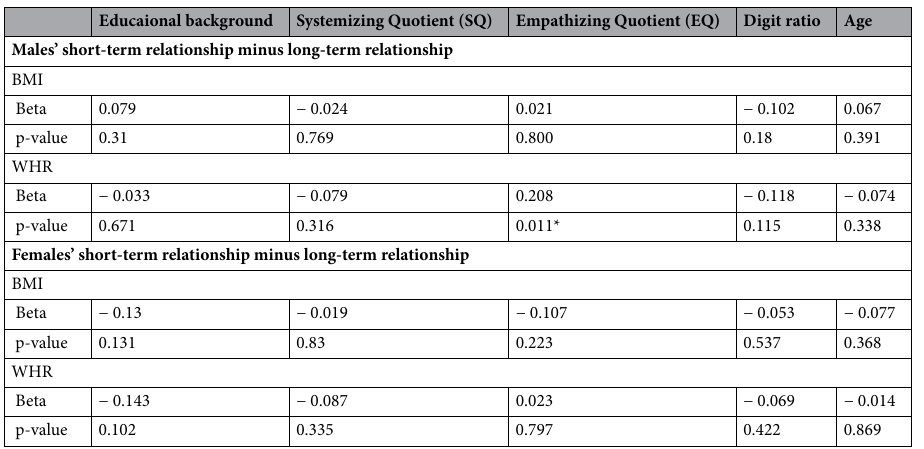
Table 3. Results of regression analysis for prediction of difference of preferred WHR/BMI in short-term relationship minus the preferred WHR/BMI in long-term relationship, separately in female and male participants. *p-value < 0.05 is considered